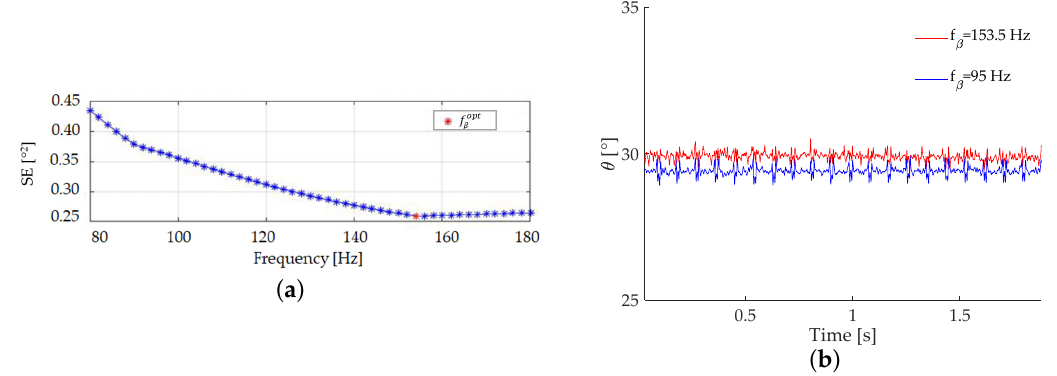
Figure 5. ( a ) Optimal cutoff frequency estimation and ( b ) effect of the cutoff frequency selection on OLA sensor data fusion (actual tilt value: 30 ◦